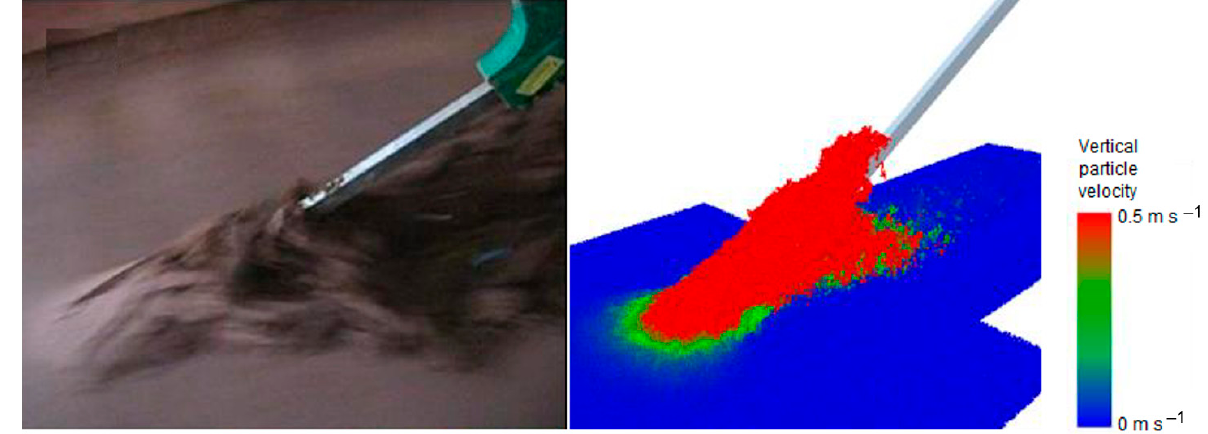
Figure 1. Discrete element method simulation of a narrow tine furrow opener operating in a moist sandy-loam soil. Modified from Barr et al. [21].